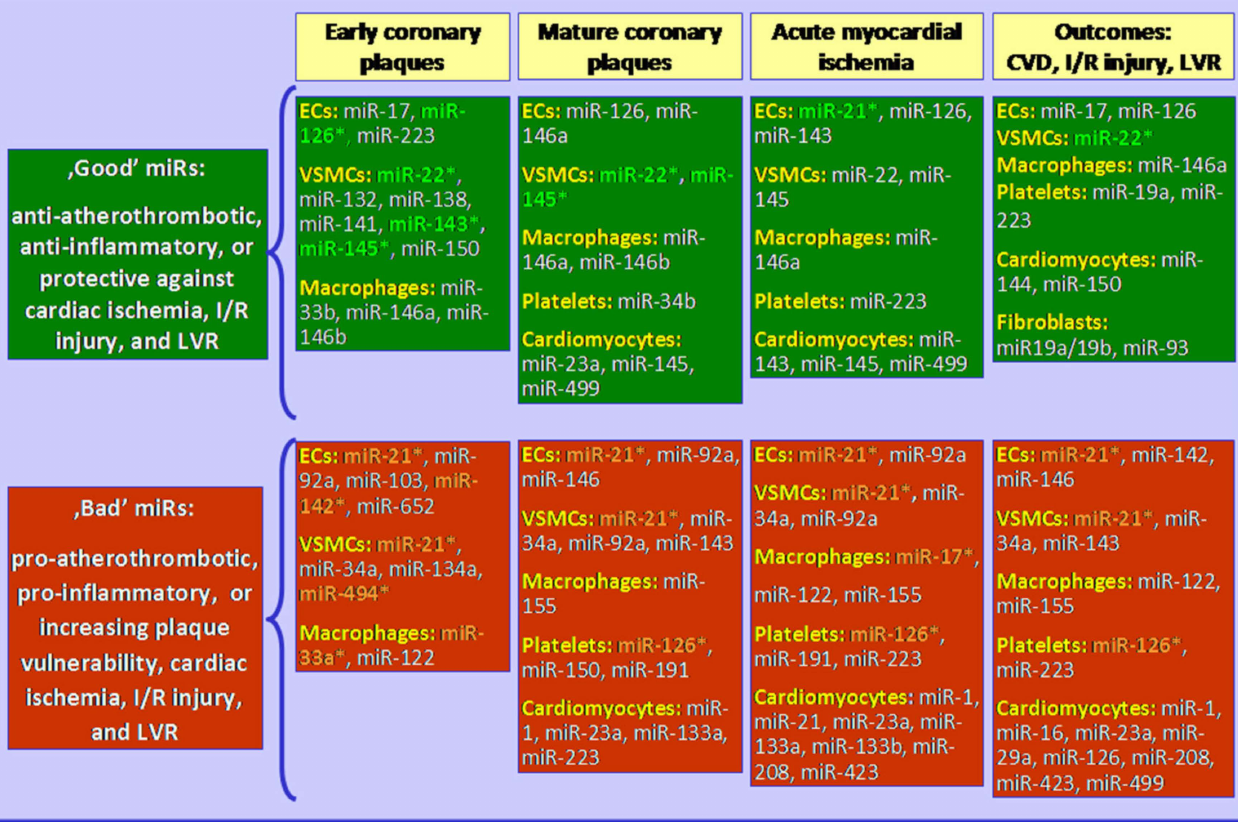
Figure 2. Selected miRs that have anti- or pro-atherothrombotic impacts on the development of atherosclerotic plaques, acute coronary syndrome, and/or post-myocardial ischemic outcomes. Please note that specific miRs are important at different stages of atherosclerosis. (1) At early stages of atherosclerosis (from fatty streaks undetectable with standard imaging tools up to intima- media complex thickening), miRs enriched in ECs, VSMCs and macrophages play a key role. Anti- atherothrombotic and anti-inflammatory effects are achieved through many signaling pathways, with a major regulatory role in lipids metabolism and inflammation. (2) At advanced stages of atherosclerosis, with development of mature plaques (easily detectable with various imaging